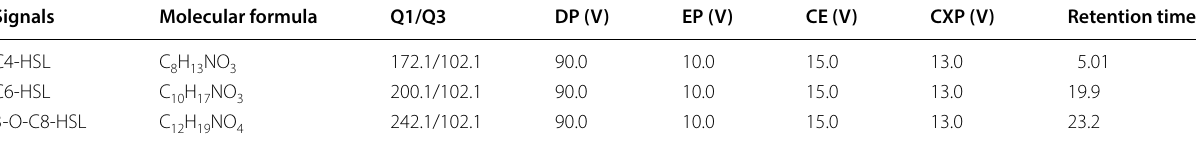
Table 2 Selected product ion m/z values and MRM parameters used for AHL analysis Signals Molecular